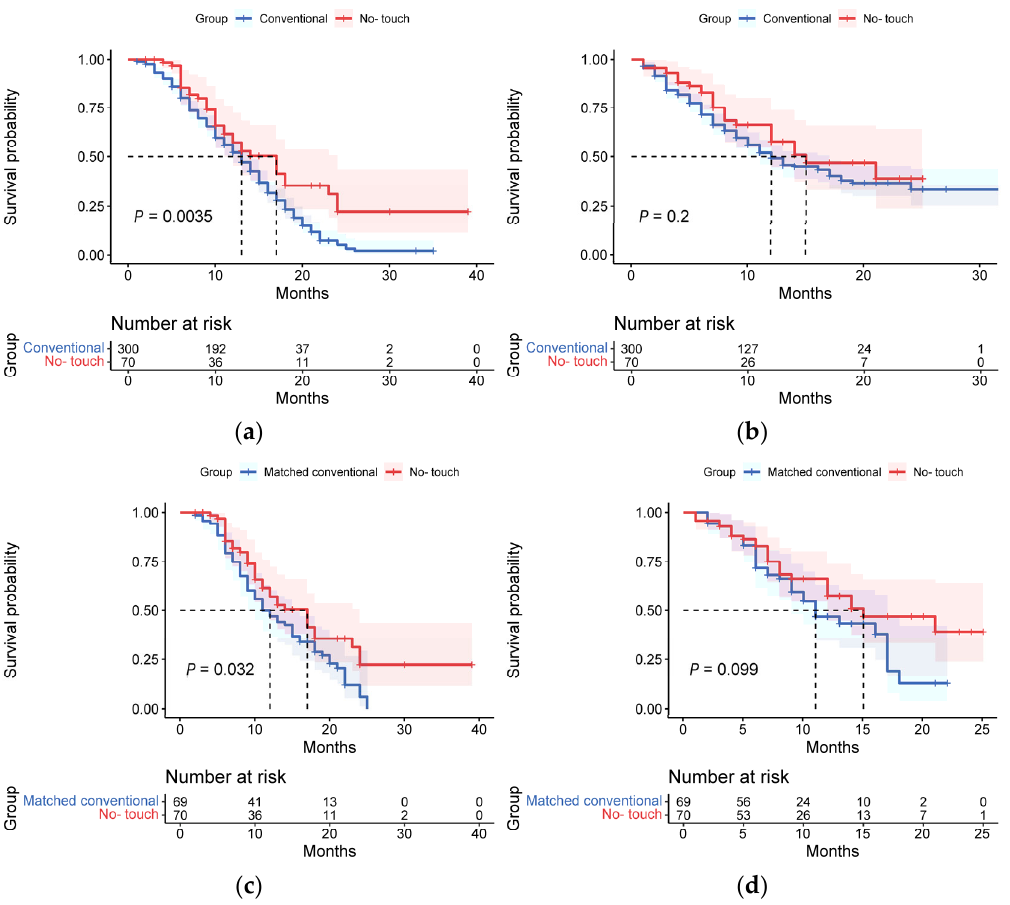
Figure 2. Long-term survival outcome between no-touch PD group and conventional PD group: ( a ) Overall survival between no-touch PD group and conventional PD group; ( b ) Disease-free survival between no-touch PD group and conventional PD group; ( c ) Overall survival between no-touch PD group and matched conventional PD group; ( d ) Disease-free survival between PD group and matched conventional PD